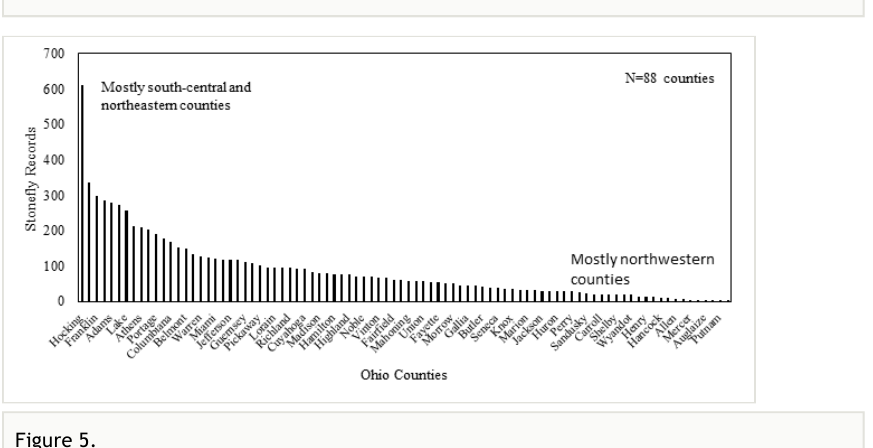
Stone fl y species richness for 88 Ohio counties (only every other name presented). Regions of the state with richest and poorest totals